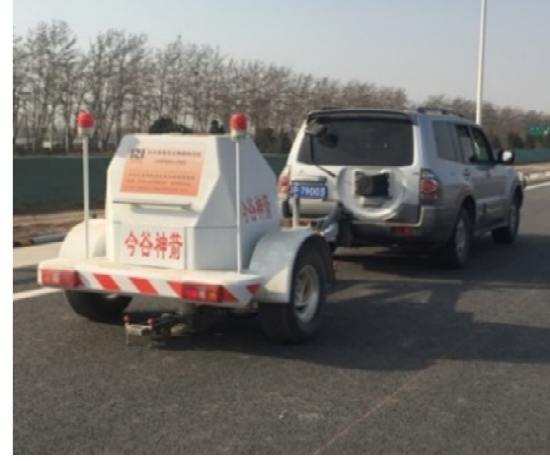
Figure 14. The FWD equipment. The modulus back calculation results are shown in Tables 6–8. Table 6. The modulus back calculation results of subgrade.